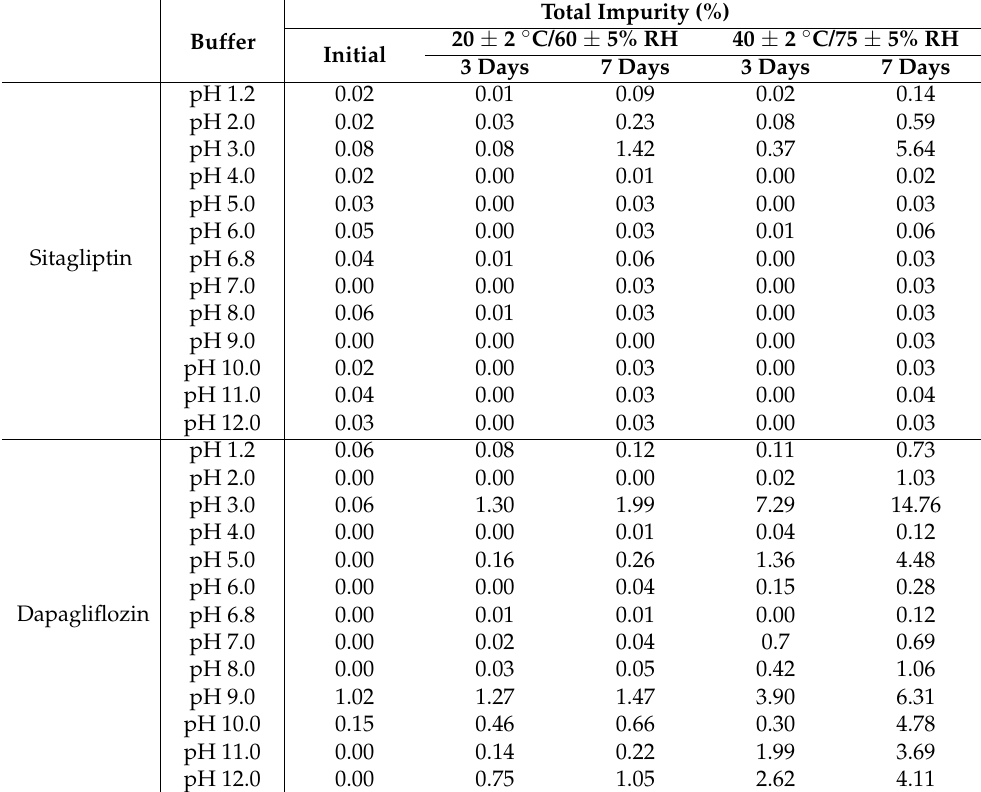
Table 5. Stability studies result of impurities in pH buffer solutions for 7